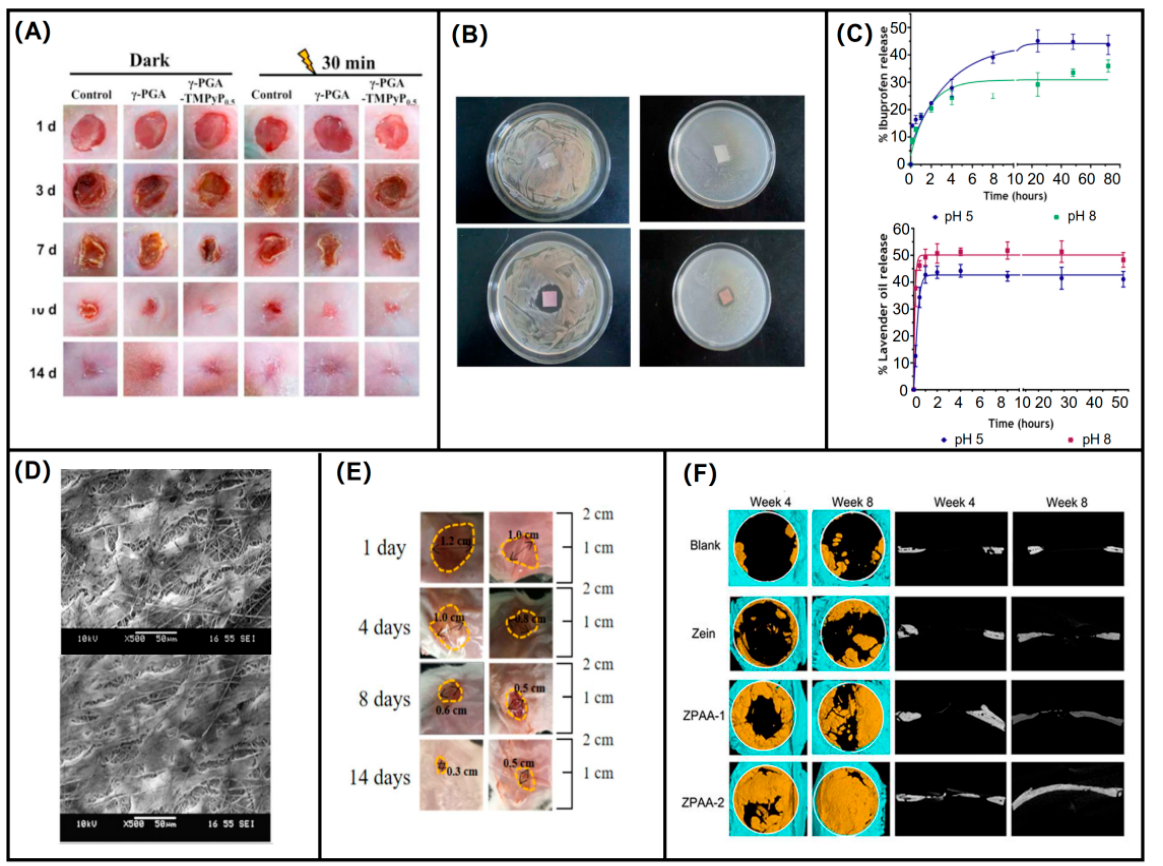
Figure 9. Application effect of poly(amino acid) electrospun nanofibers. ( A ) Photographs of wounds at different time intervals after treatment with different environments and materials [140]; ( B ) bac- terial growth inhibition halos against Staphylococcus aureus and E. coli for PVA/L-H and PVA/L- H/Ag nanofibers [141]; ( C ) characterization of the IBP and LO in vitro release profile at pH 5 and pH 8 [142]; ( D ) SEM images showing the cell–biomaterial interactions on day 10 and day 15 on PLLA/PAA/Col I&III nanofibers [144]; ( E ) wound healing in the experimental and control groups at different times [149]; ( F ) three-dimensional micro-computed tomography reconstructed images of PAsp nanofibrous membrane treatment at 4 and 8 weeks postoperatively [159], the diameter of calvarial- defect model is 6 mm